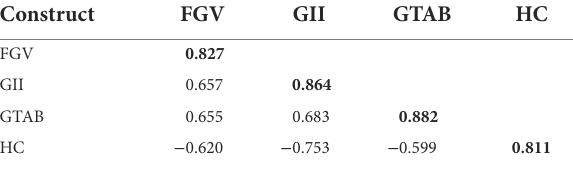
FGI, Farmer Green Values; GII, Green Innovative Intention; GTAB, Green Technology Adoption Behavior; HC, Health Consciousness. The bold values are the results for corresponding statistics for whole variable not the